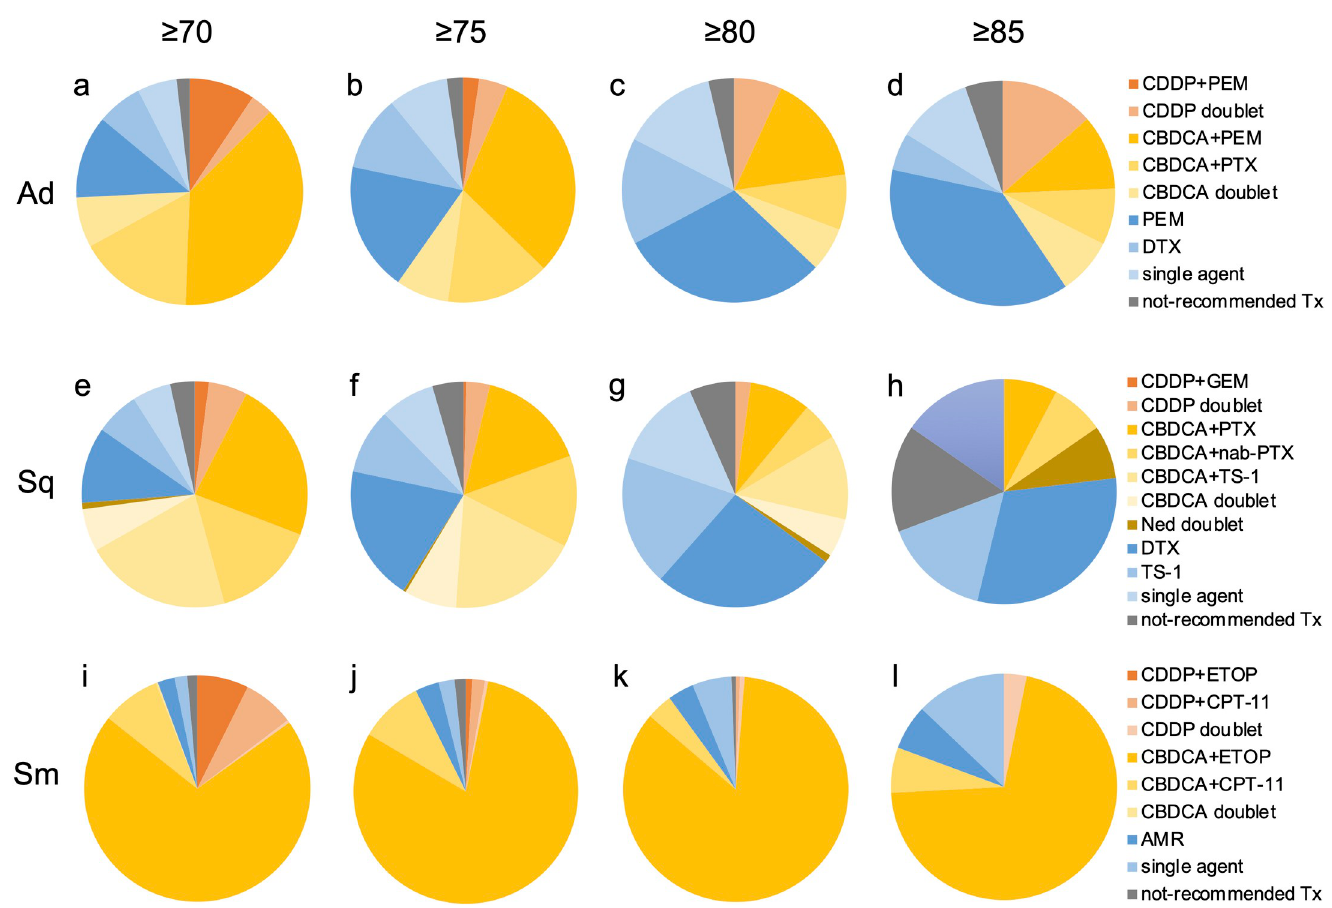
Fig 5. First-line choice of cytotoxic chemotherapy in older patients. (a)-(d) adenocarcinoma, (e)-(h) squamous cell carcinoma, and (i)-(l) small cell carcinoma. Ad, adenocarcinoma; Sq, squamous cell carcinoma; Sm, small cell carcinoma; CDDP, cisplatin; PEM, pemetrexed; CBDCA, carboplatin; PTX, paclitaxel; DTX, docetaxel; not-recommended Tx, not-recommended chemotherapy; GEM, gemcitabine; nab-PTX, nab-paclitaxel; Ned, nedaplatin; ETOP, etoposide; CPT-11, irinotecan; AMR, amrubicin.